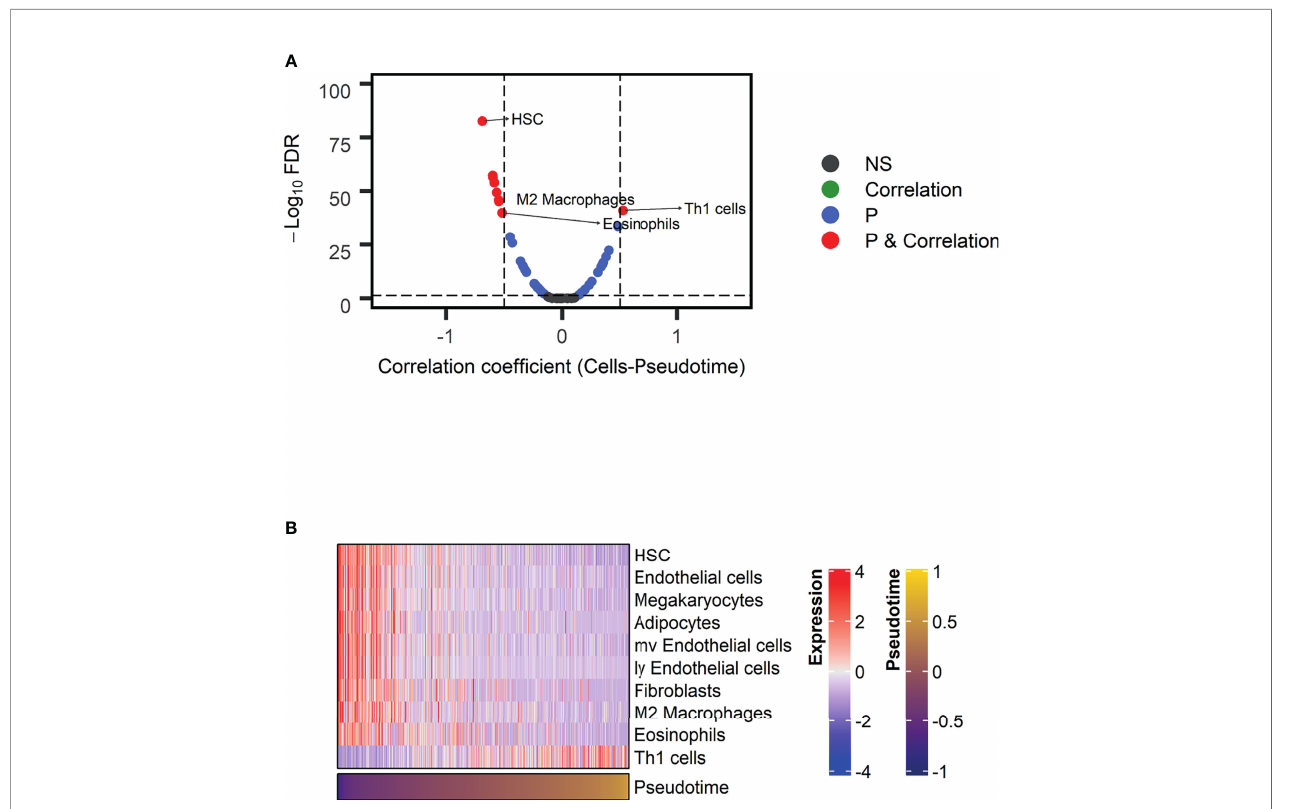
FIGURE 6 | Immune and stromal cells associated with pseudotime in the TCGA-LUAD dataset. (A) A volcano plot representing immune cells associated with pseudotime is shown. Cell types with correlation coef fi cients above 0.5 are plotted as red dots. Cell types with FDR below 0.05 and correlation coef fi cients below 0.5 are plotted as blue dots. Among them, immune cells were annotated. (B) A heatmap representing immune and stromal cells associated with pseudotime is